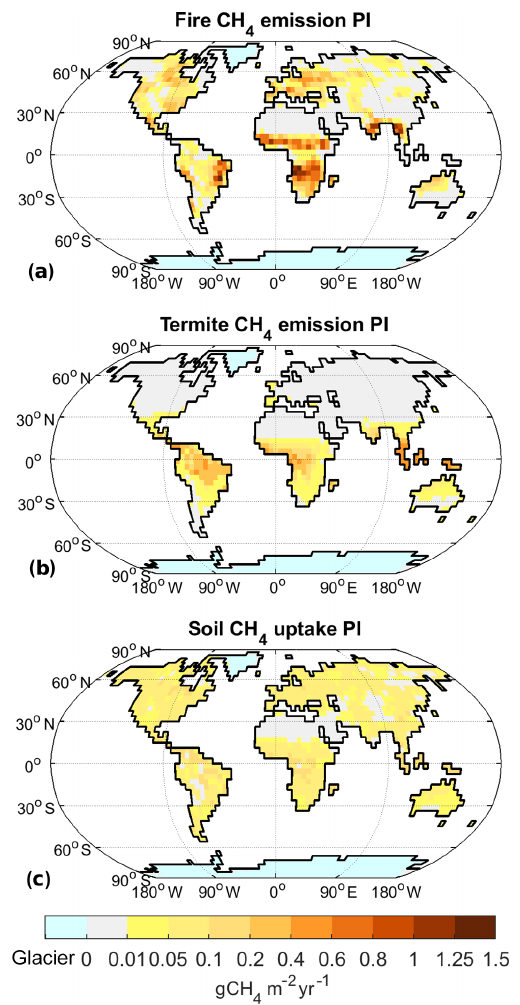
Figure 5. Non-wetland CH 4 emissions for PI climate: annual emis- sions of CH 4 from fires (a) and termites (b) , as well as annual soil uptake of CH 4 (c) . In comparison to other fluxes, soil uptake has the opposite direction